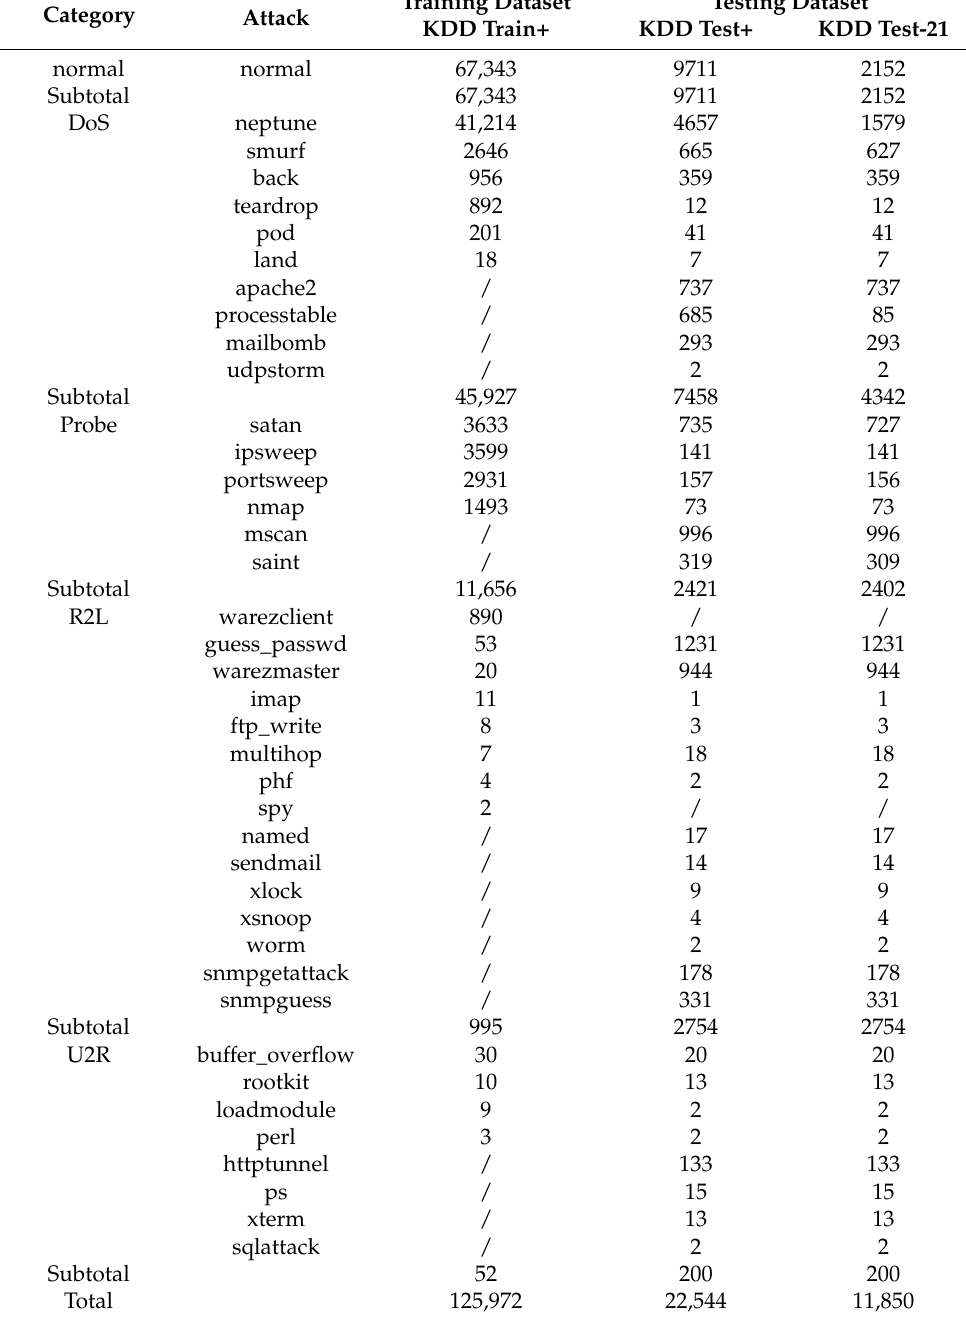
Table 1. The class distribution of the NSL-KDD